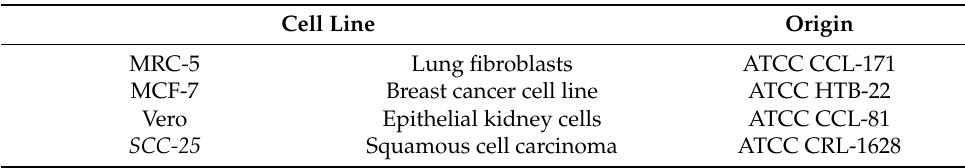
Table 3. Origin information of experimental